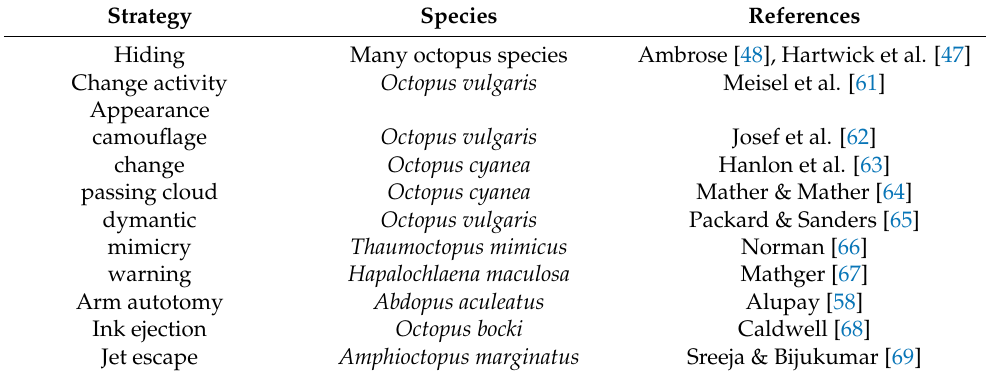
Table 1. Octopus antipredator